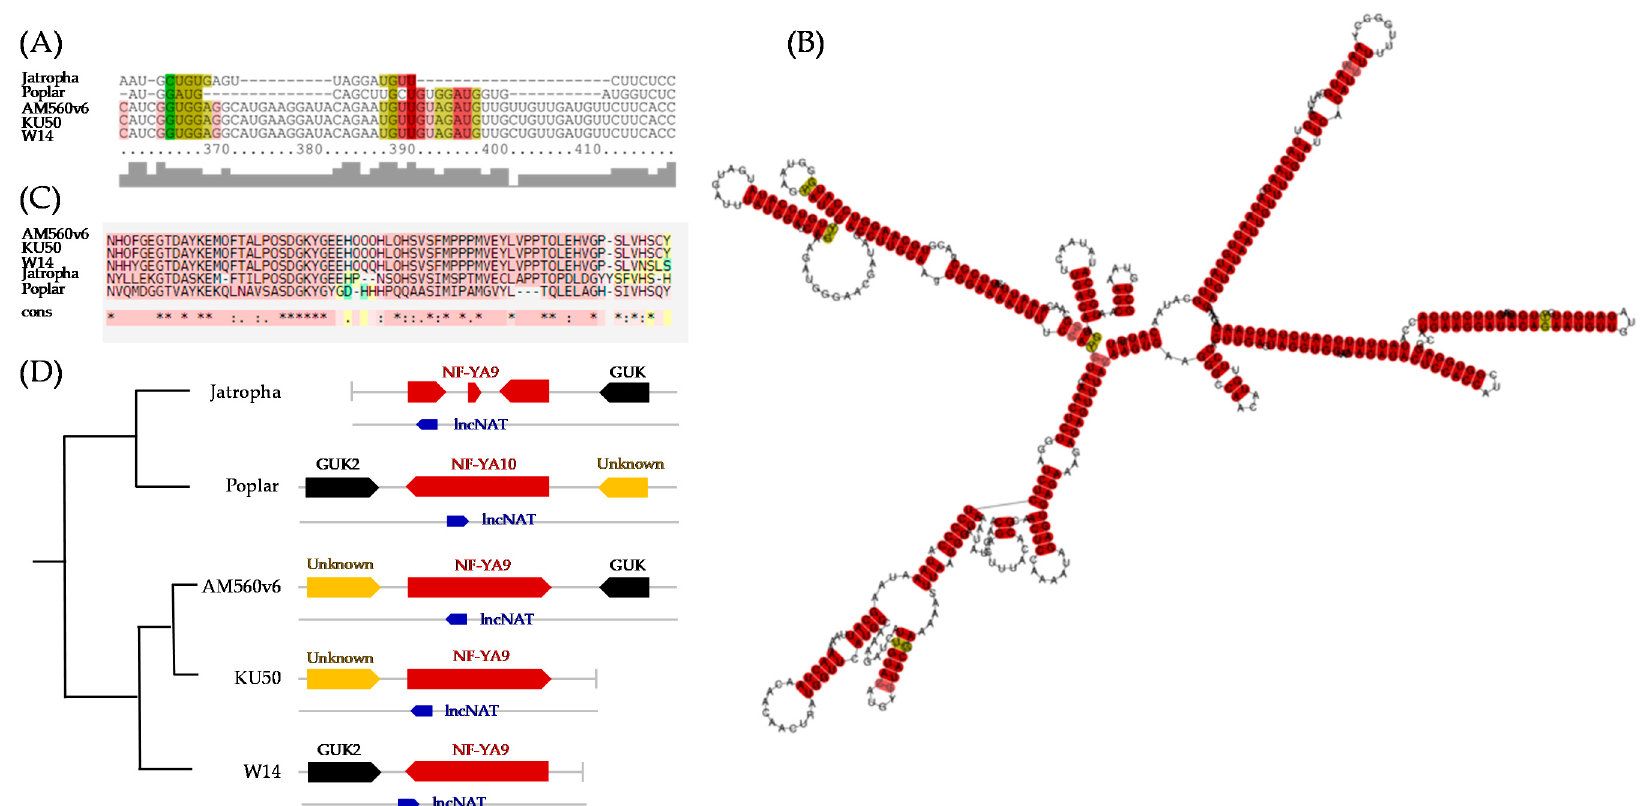
Figure 6. Characteristics of the putative long noncoding natural antisense transcripts (lncNAT), ncM17949. ( A ) Consensus alignment of the lncNAT ncM17949 from cassava AM560, at position 370–410, and its orthologous sequences from cassava KU50, cassava W14, Jatropha, and poplar annotated by LocARNA tool. ( B ) Consensus secondary structure of lncNAT, ncM17949 in cassava. ( C ) Similarity of nuclear factor Y protein sequences in cassava AM560, KU50, W14, Jatropha, and poplar annotated by T-Coffee tool. Alignments in pink, yellow, and green colors respectively, represent good, average, and bad consistency among the amino acid sequences. ( D ) Orthologs and syntenic features of lncNAT, ncM17949 in Jatropha, poplar, and cassava cultivars AM560v6, KU50, and W14.